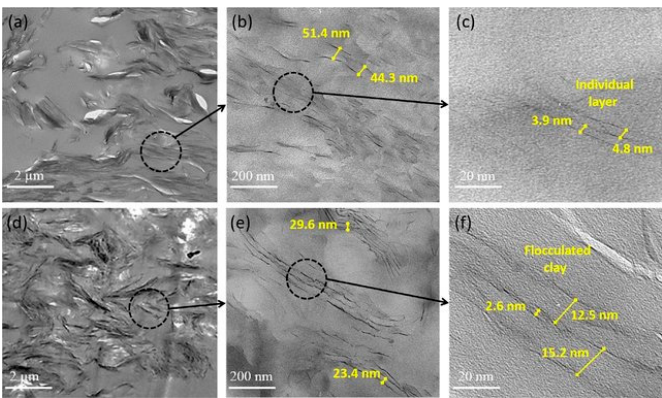
Figure 13. TEM micrographs of epoxy-2.5 wt% of DNA-clay ( a – c ) and epoxy-5 wt% of DNA-clay ( d – f ) nanocomposites. Reproduced with permission from Reference [137]. Open Access 2016, Springer Nature.